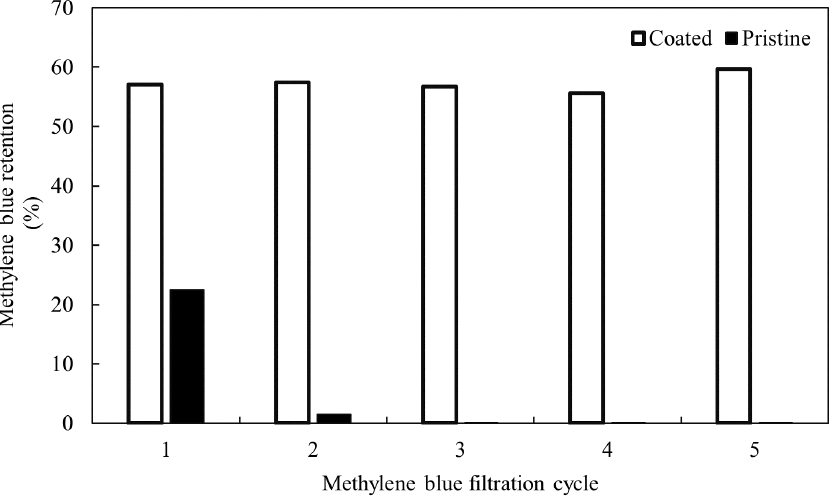
Figure 7. Ten-ppm MB solutions were filtrated by a pristine and coated UF membranes five times. Coating was removed and new coatings of CNFs (6.5 g/m 2 ) were built up again after each filtration of fresh dye solution.